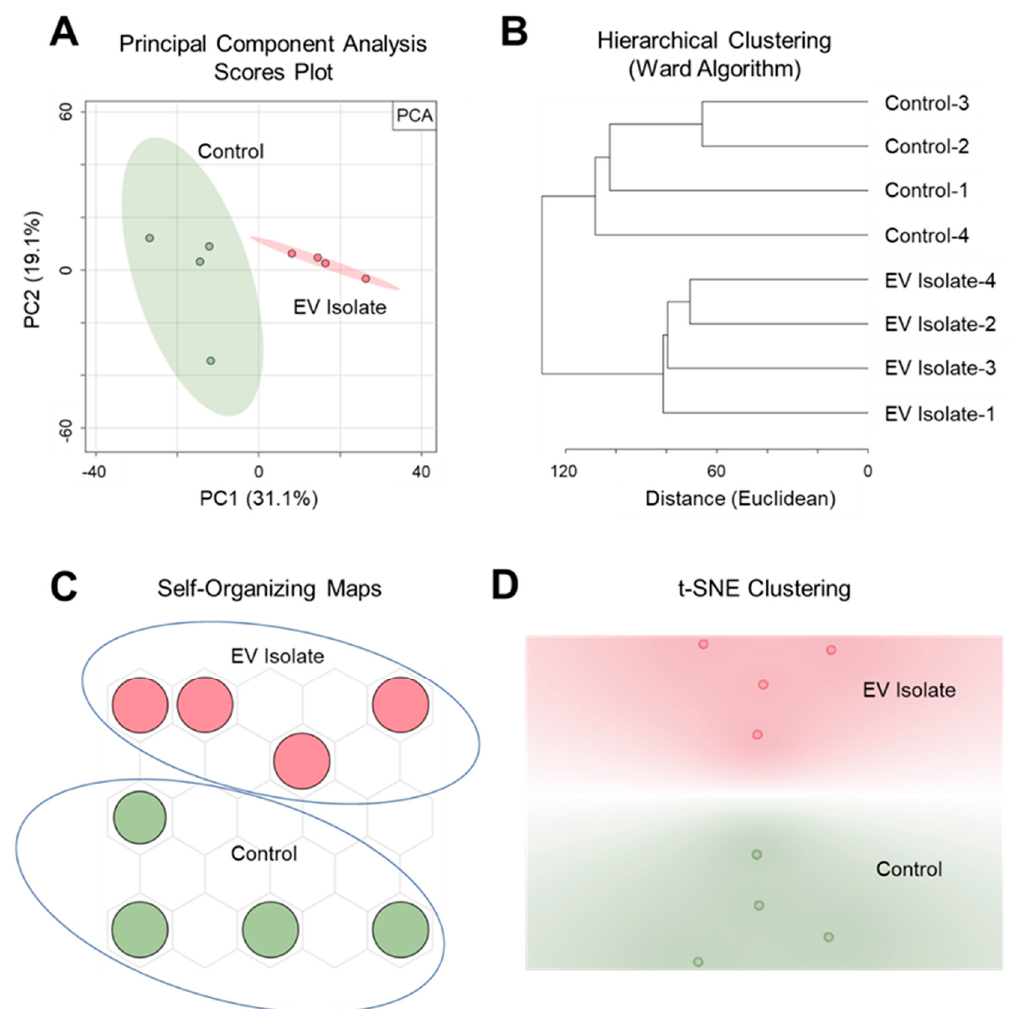
Figure 2. Unsupervised multivariate statistical clustering differentiates metabolomic profiles of the O. formigenes EV isolate and EV ‐ free control. Clear separation and analytical distinction between the EV isolate and control was demonstrated using ( A ) principal component analysis (50.2% of the variance represented in 2 PCs), ( B ) hierarchical clustering (Euclidean distancing, Ward clustering), ( C ) self ‐ organizing maps, and ( D ) t ‐ stochastic neighbor embedding (initialized with PCA pre ‐ processing).